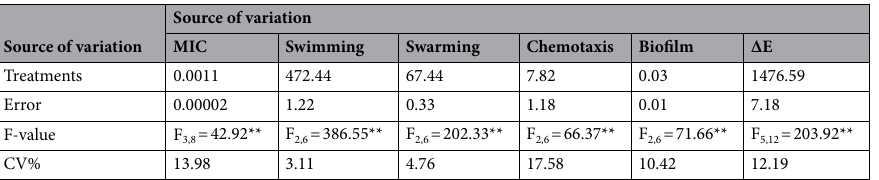
Table 2. Analysis of variance (ANOVA) of chemotaxis, swimming-, swarming- motility, biofilm production and discoloration level (ΔE) of mushroom cap inoculated by Pseudomonas tolaasii Pt18 under the effect of biosynthesized AgNPs. **Significant at 5% probability